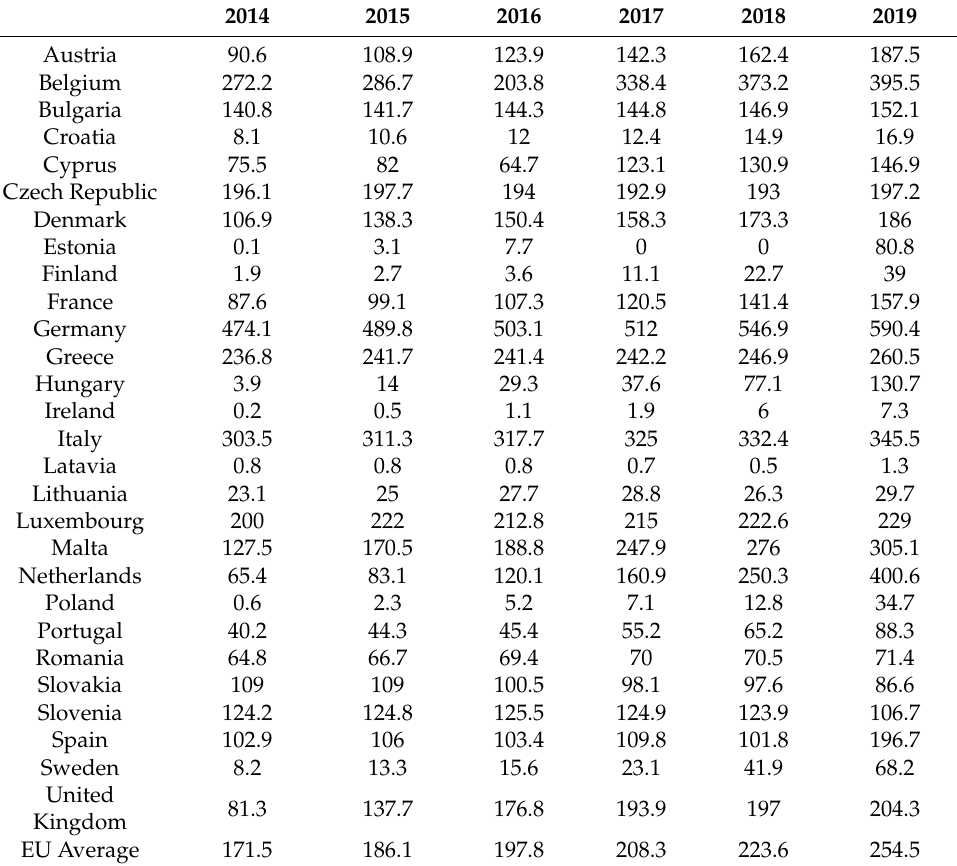
Table 6. Photovoltaic capacity in European Union countries per inhabitant in years 2014–2019